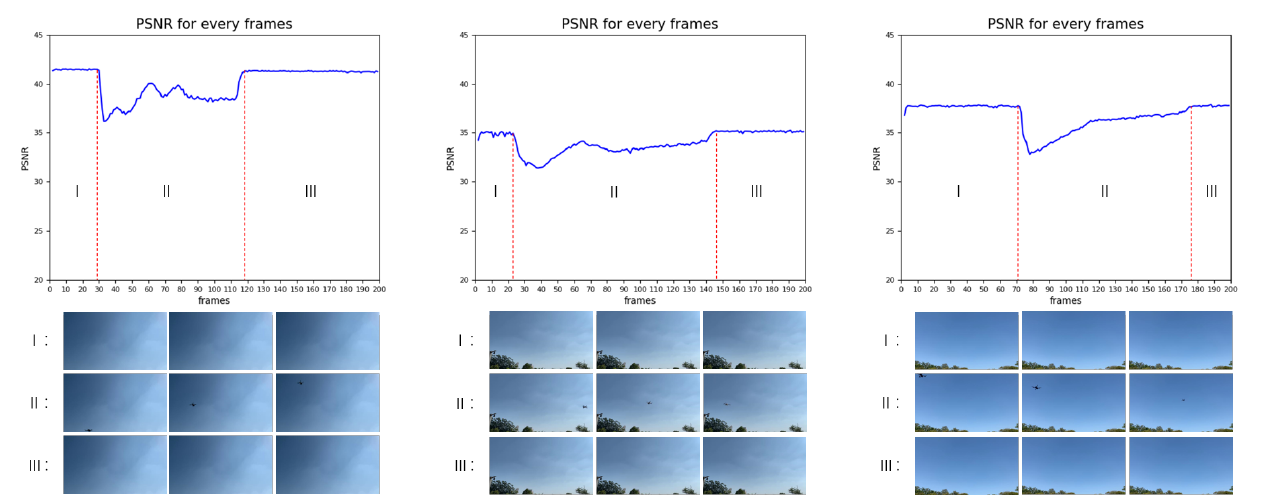
Figure 9. The two classification scenarios categorized in this study. Each frame has its own PSNR. The curves are divided into three stages: I and III are normal stages, whereas II is the abnormal stage where the UAV appears. In stage II, there is a significant drop in the PSNR curve, which can be used to determine the appearance of abnormalities. The bottom of the curve shows part of the frame of the phase corresponding to this